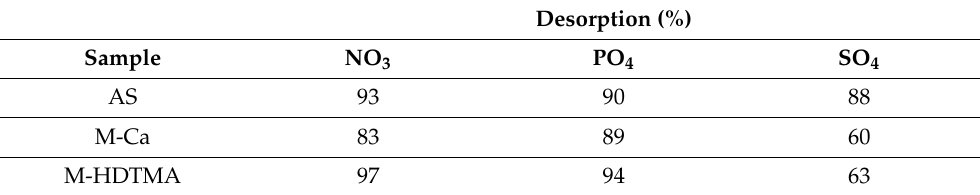
Table 8. Percentage desorption (phytoavailability) of NO 3 , PO 4 , and SO 4 from raw and modified